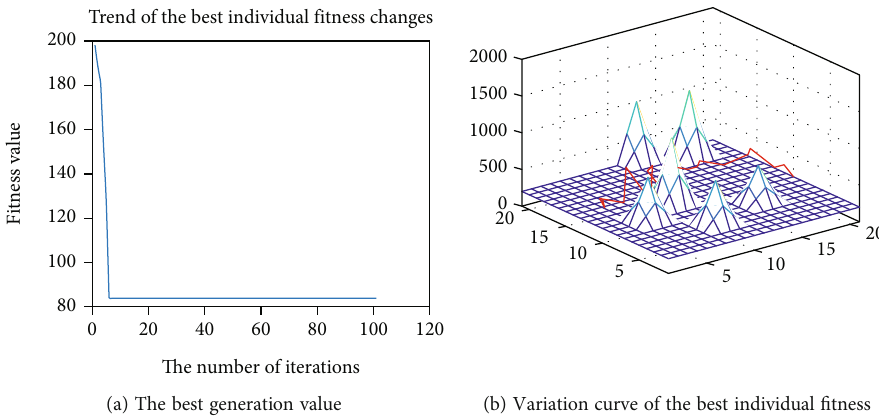
Figure 9: End three: the best generation value and path planning